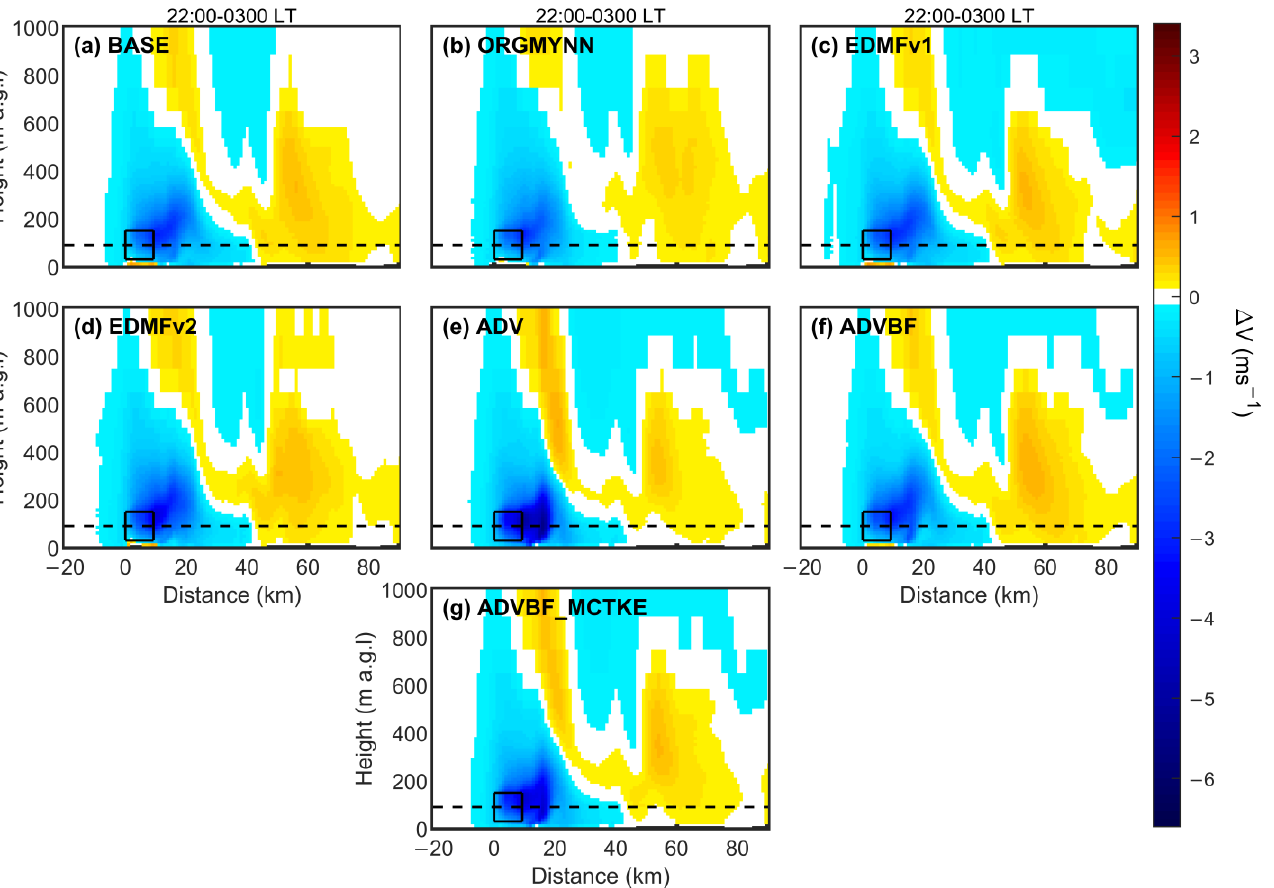
Figure 10. Same as in Figure 8, but for wind speed. Vertical cross-sections of the wind speed variations along the prevailing wind direction in all simulations are depicted in Figure 10. Wind speed deficits from the surface to the top height of the rotor area disappear after ~40 km downwind, and wind speed acceleration starts at this distance and extends downwind to the eastern border of the domain in all simulations. The distributions of negative and positive wind speed differences with height and downwind of the domain are generally in agreement with each other. There is a wind speed acceleration below the rotor area within the wind farm, due to the enhanced TKE-induced downward mixing of air with higher momentum at upper levels, except for the ADV and ADVBF_MCTKE simulations. The reason for the deceleration in ADV